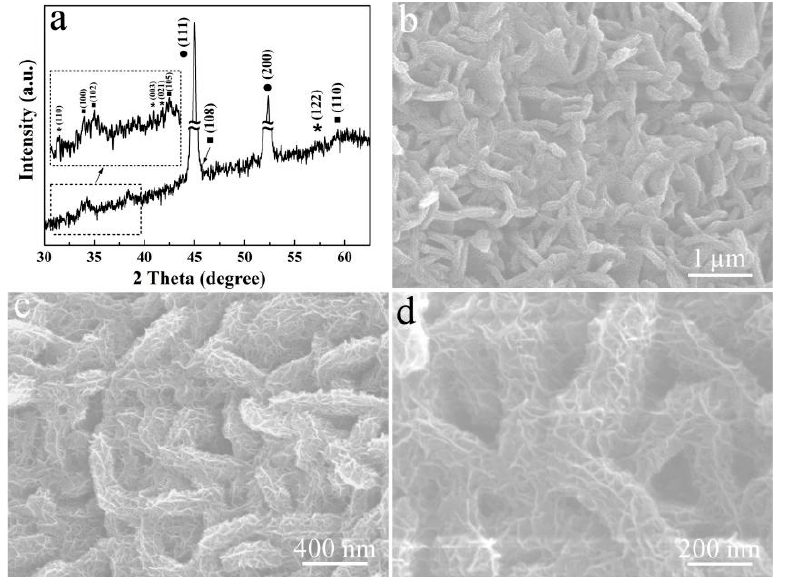
Figure 2. ( a ) XRD pattern and ( b – d ) FE-SEM images of Co(OH) 2 /Ni 3 S 2 heterostructure at different